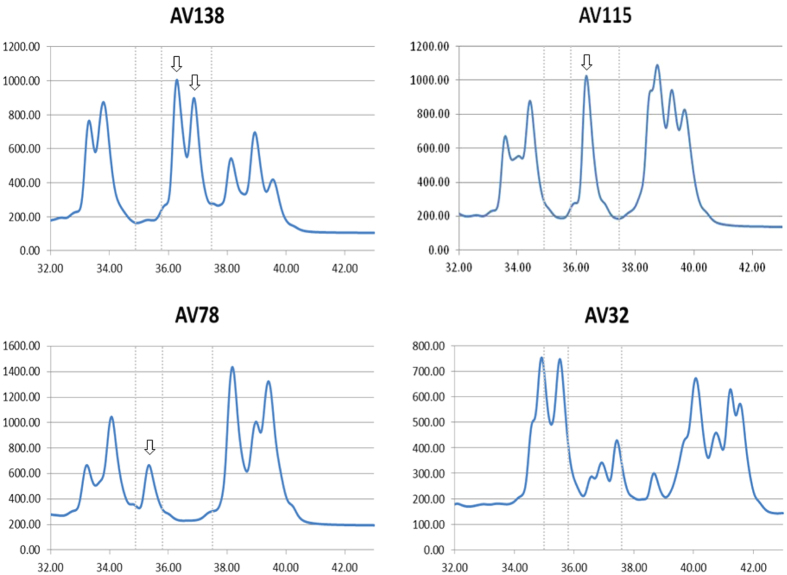
Examples of chromatograms of the RP-HPLC oat groups.AV138 (Pattern I); AV115 (Pattern II); AV78 (Pattern III); AV32 (Other). Arrows indicate the peaks used as reference for establishing the groups within each range (dotted line) of elution time.